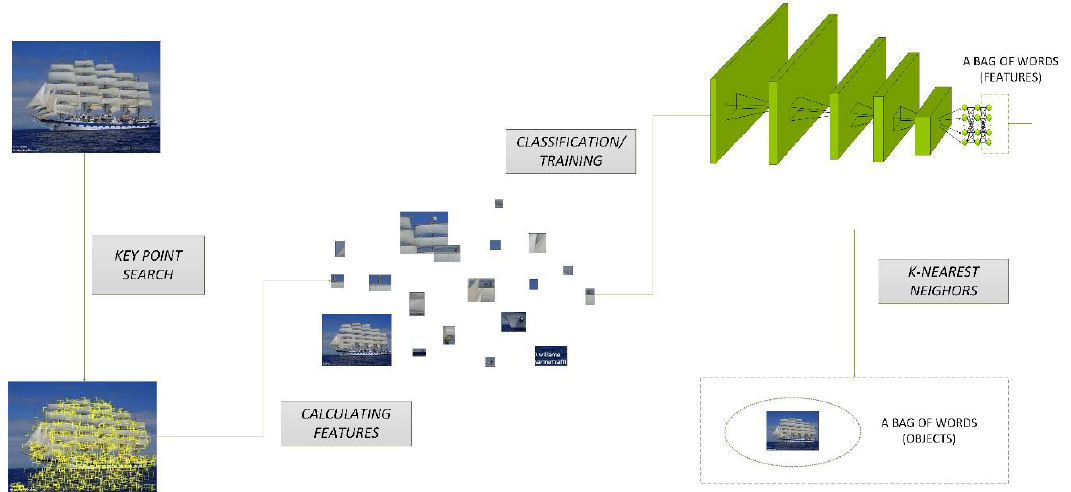
Figure 1. Graphic visualization of the proposed model.